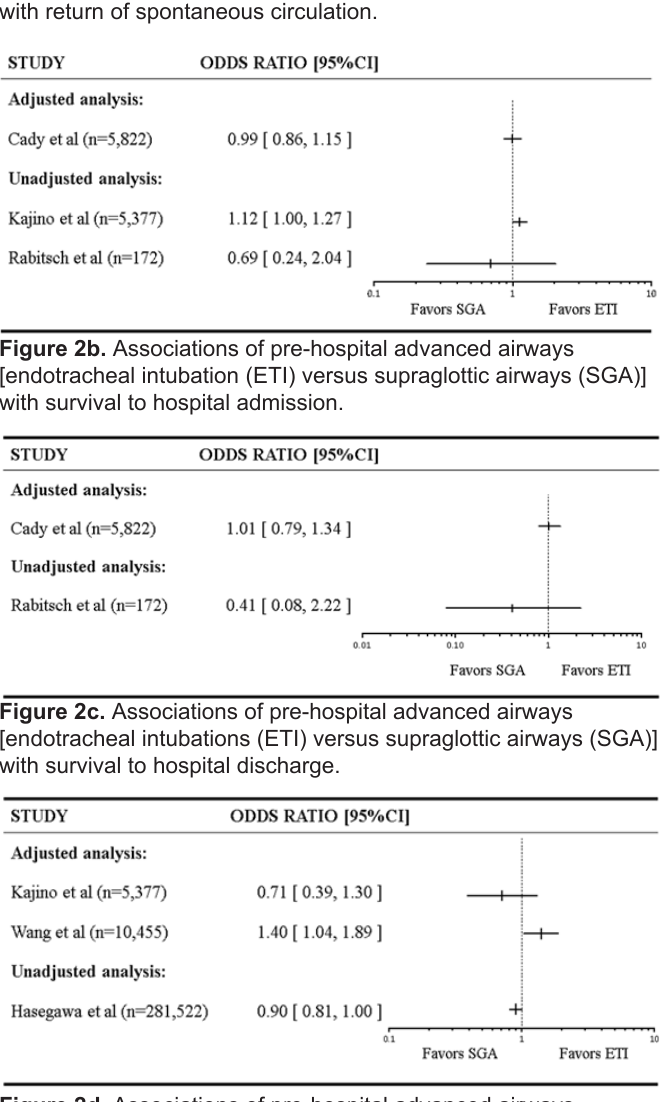
Figure 2d. Associations of pre-hospital advanced airways [endotracheal intubations (ETI) versus supraglottic airways (SGA)] with favorable neurological or functional